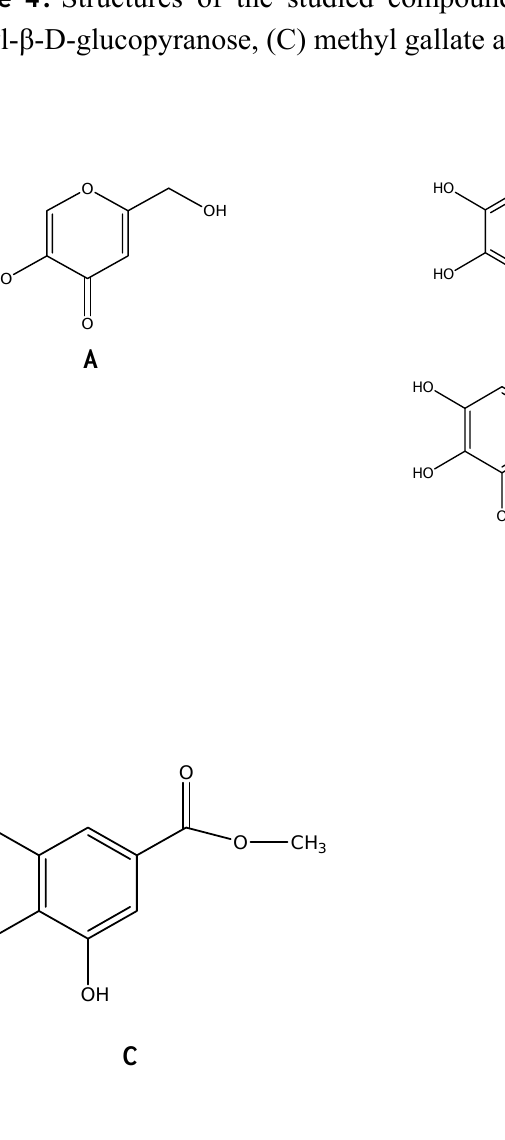
Figure 4. Structures of the studied compounds. (A) kojic acid, (B) 1,2,3,4,6-penta-O- galloyl- β -D-glucopyranose, (C) methyl gallate and (D) ionized gallic